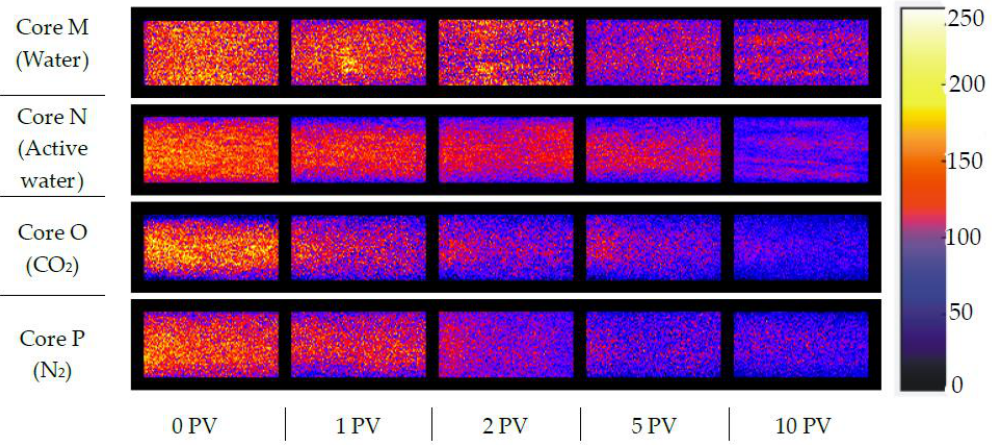
Figure 8. MRI images of the cores under different injection media.